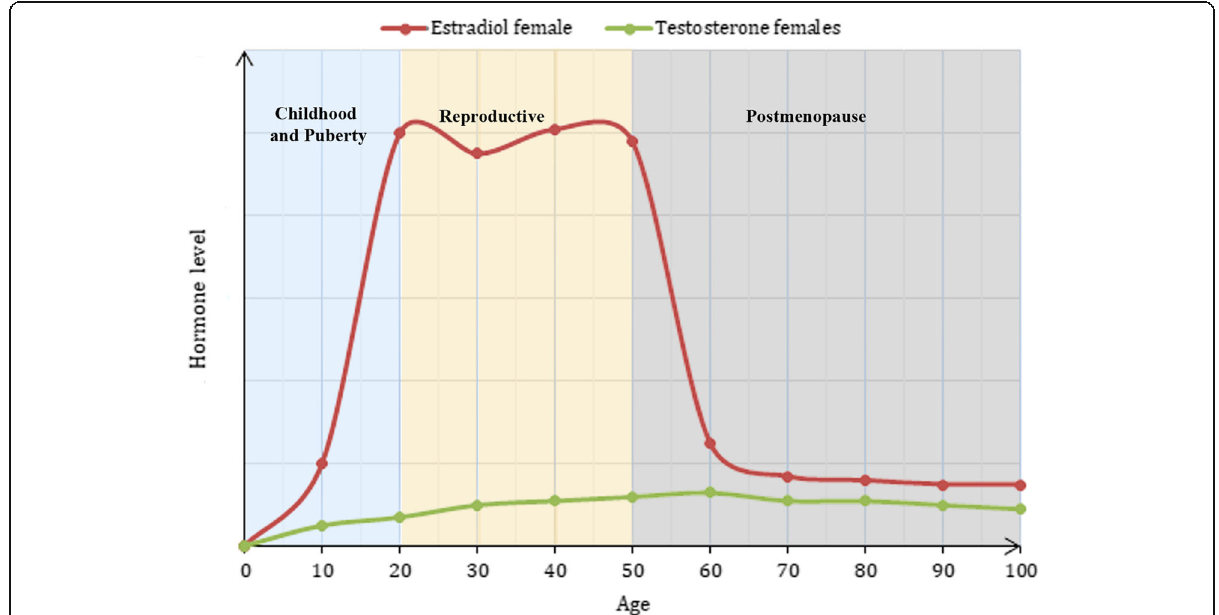
Fig. 1 Variations in hormone levels during the lifetime of